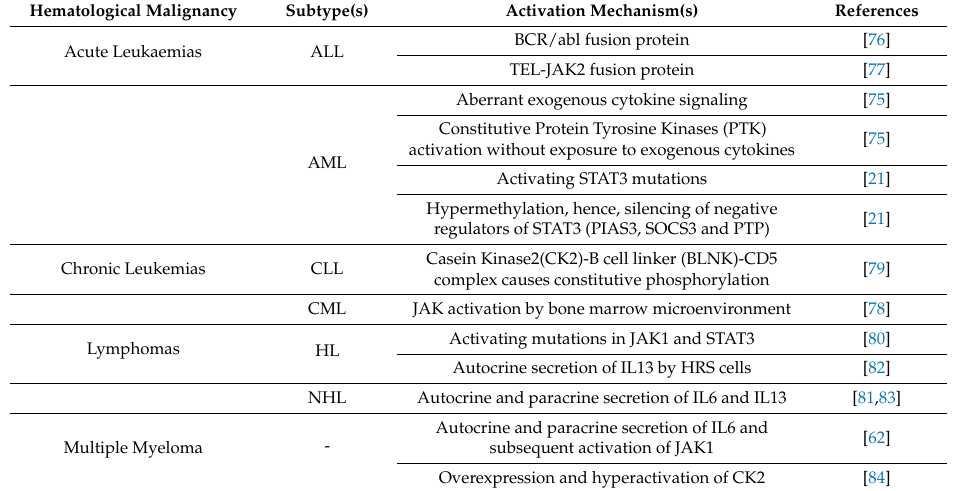
Table 1. Selected molecular mechanisms of aberrant activation of STAT3 in hematological